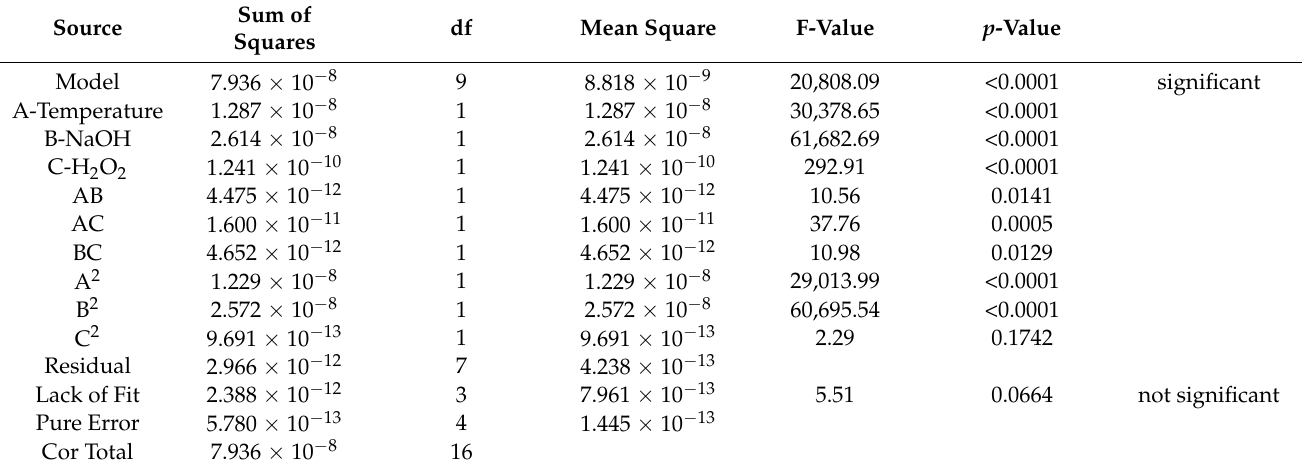
Table 4. ANOVA results.